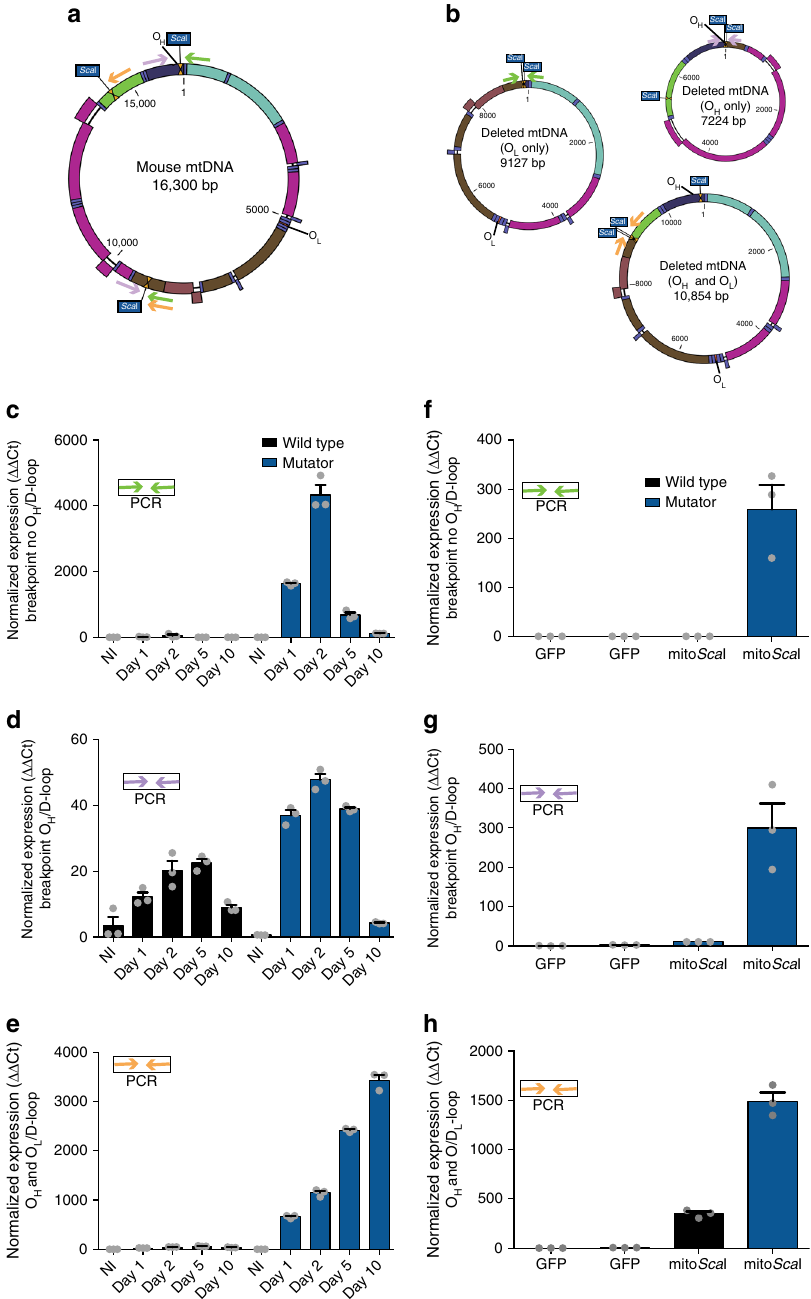
Fig. 4 Quanti fi cation of mtDNA rearrangements after DSB in the mutator mouse. a Diagram of wild-type C57BL6/J mtDNA illustrating the location and number of Sca I sites and primers used to quantify rearrangements following Sca I infection. Green primers amplify rearrangements that do not contain the origin of replication of the heavy-strand (O H ), purple primers amplify rearrangements that contain the O H , orange primers amplify rearrangements that contain the O H and the O L . b Diagrams of putative C57BL6/J partially-deleted mtDNA after Ad-mito Sca I-HA infection and primers used to quantify rearrangements. One deleted molecule does not contain the O H (green primers) whereas the other deleted molecule contains the O H (purple primers). The last deleted molecule contains both the O H and the O L (orange primers). Quanti fi cation of the breakpoint without O H in ( c ) mutator and wild-type fi broblasts at 1, 2, 5, and 10 days and ( f) mutator and wild-type liver at 5 days after Ad-mito Sca I infection. Levels of the breakpoint without O normalized to a region in the D-loop. Quanti fi cation of the breakpoint with O H in ( d ) mutator and wild-type fi broblasts at 1, 2, 5, and 10 days and ( g ) mutator and wild-type liver at 5 days after Ad-mito Sca I-HA infection. Levels of the breakpoint with O H were normalized to a region in the D-loop. Quanti fi cation of the breakpoint with O H and O L in ( e ) mutator and wild-type fi broblasts at 1, 2, 5, and 10 days and ( h ) mutator and wild-type liver at 5 days after Ad-mito Sca I-HA infection. Levels of the breakpoint with O H and O L were normalized to a region in the D-loop. NI indicates not infected. Quanti fi cation was performed using comparative ΔΔ Ct method. Error bars (s.e.m.) derive from technical